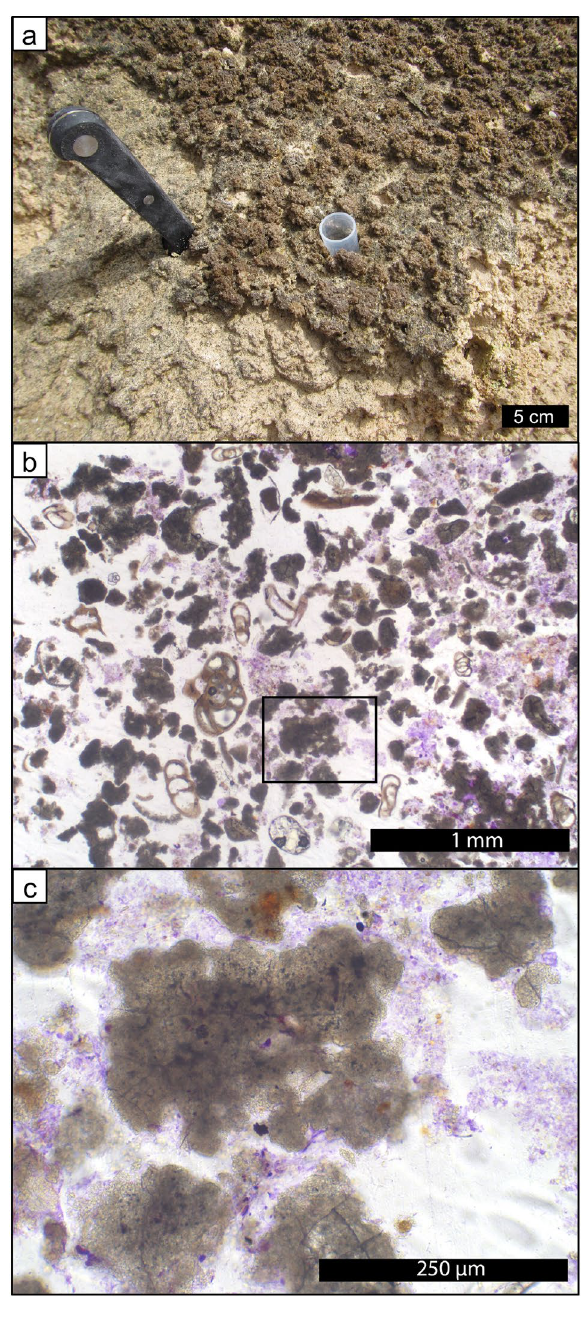
Figure 4. Rounded irregular micritic grain production in core beneath unlithified pustular sheet mats. ( a ) one inch diameter core taken through pustular sheet mat in Nilemah embayment; ( b ) photomicrograph of a thin section made from the core of sediment underlying the pustular sheet mat showing sediment comprised of abundant irregular micritic grains released from degrading Entophysalis and fresh foraminifera; and ( c ) shows a high resolution of the boxed area from ( b ) showing micritic grains formed within the pustules easily recognizable by their irregular shapes and peloidal